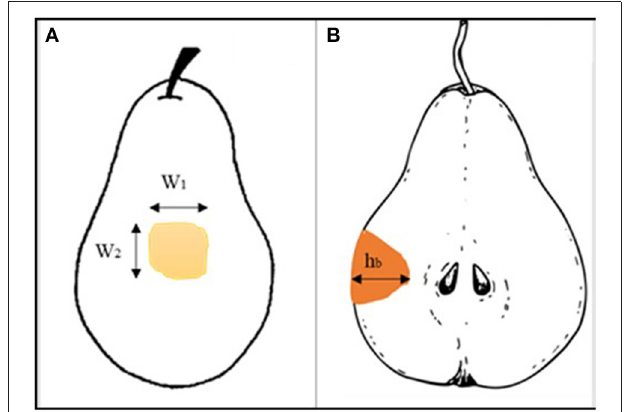
FIGURE 2 | Bruise measurements (A) bruise diameter and (B) bruise